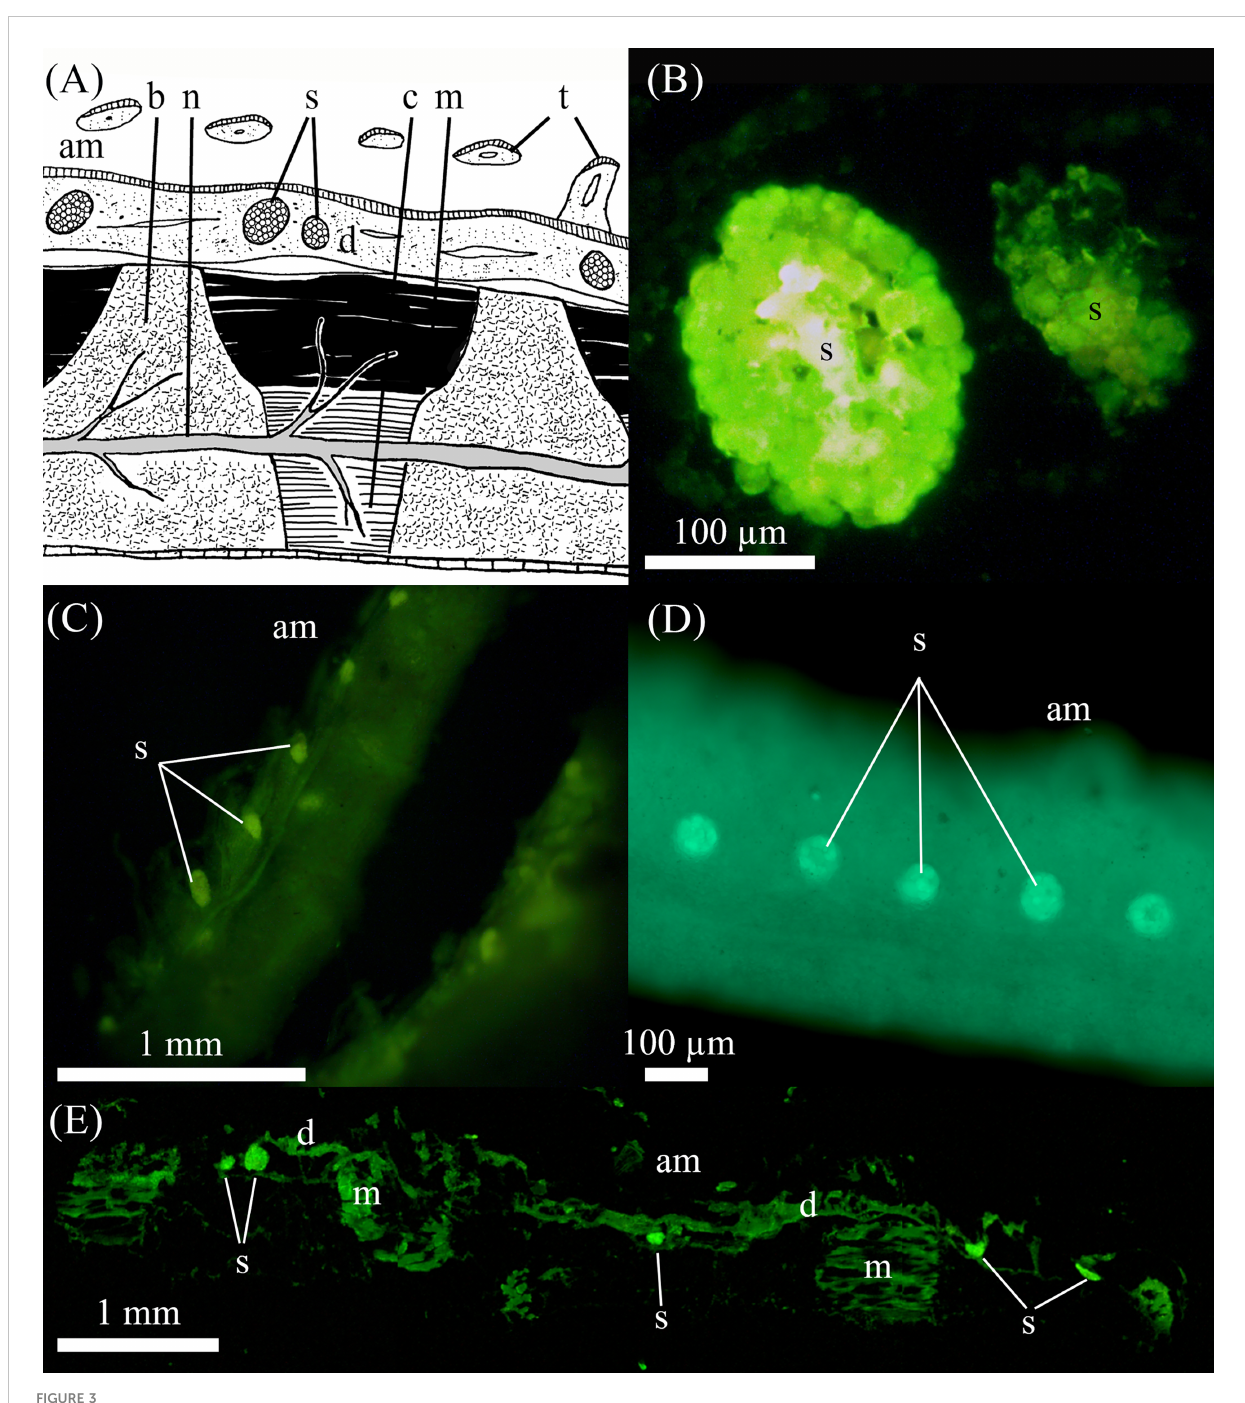
epi fl uorescent blue light stimulation; in toto observation of pinnules under blue light stimulation in (C) Thalassometra cf . gracilis and (D) A bi fi da ; (E) sagittal cryosection into an arm piece of M . cf. aotearoa observed under epi fl uorescent blue light stimulation. am: ambulacral groove, b: